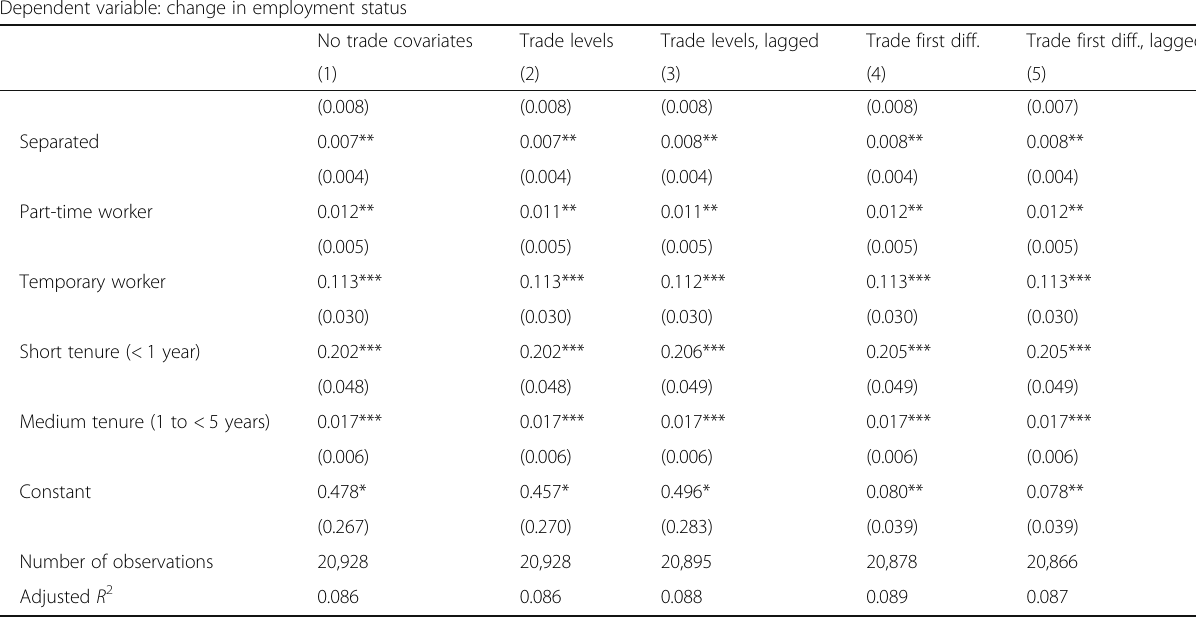
Table 2 Linear regressions of changes in employment status on trade variables and individual characteristics (Continued) Dependent variable: change in employment